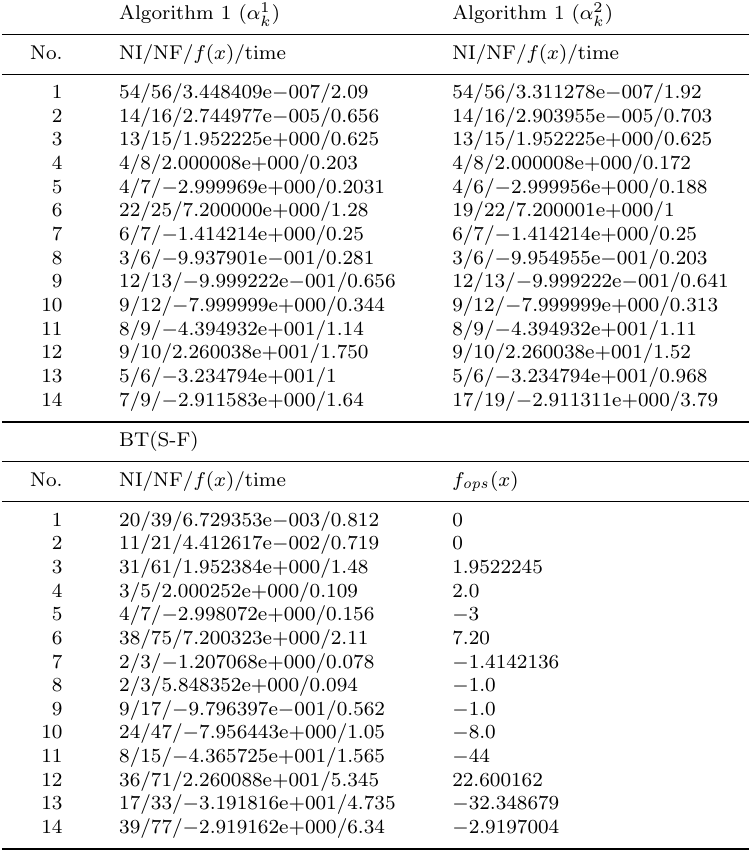
Table 2. Numerical results of the tested